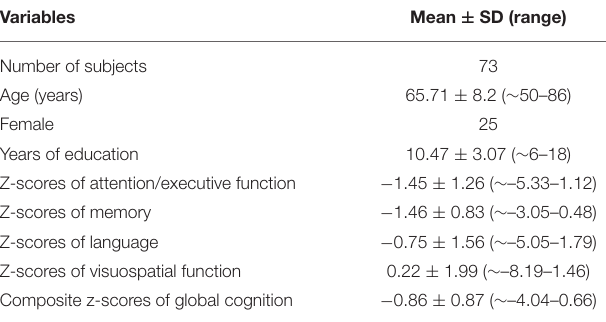
TABLE 2 | Summary of participant